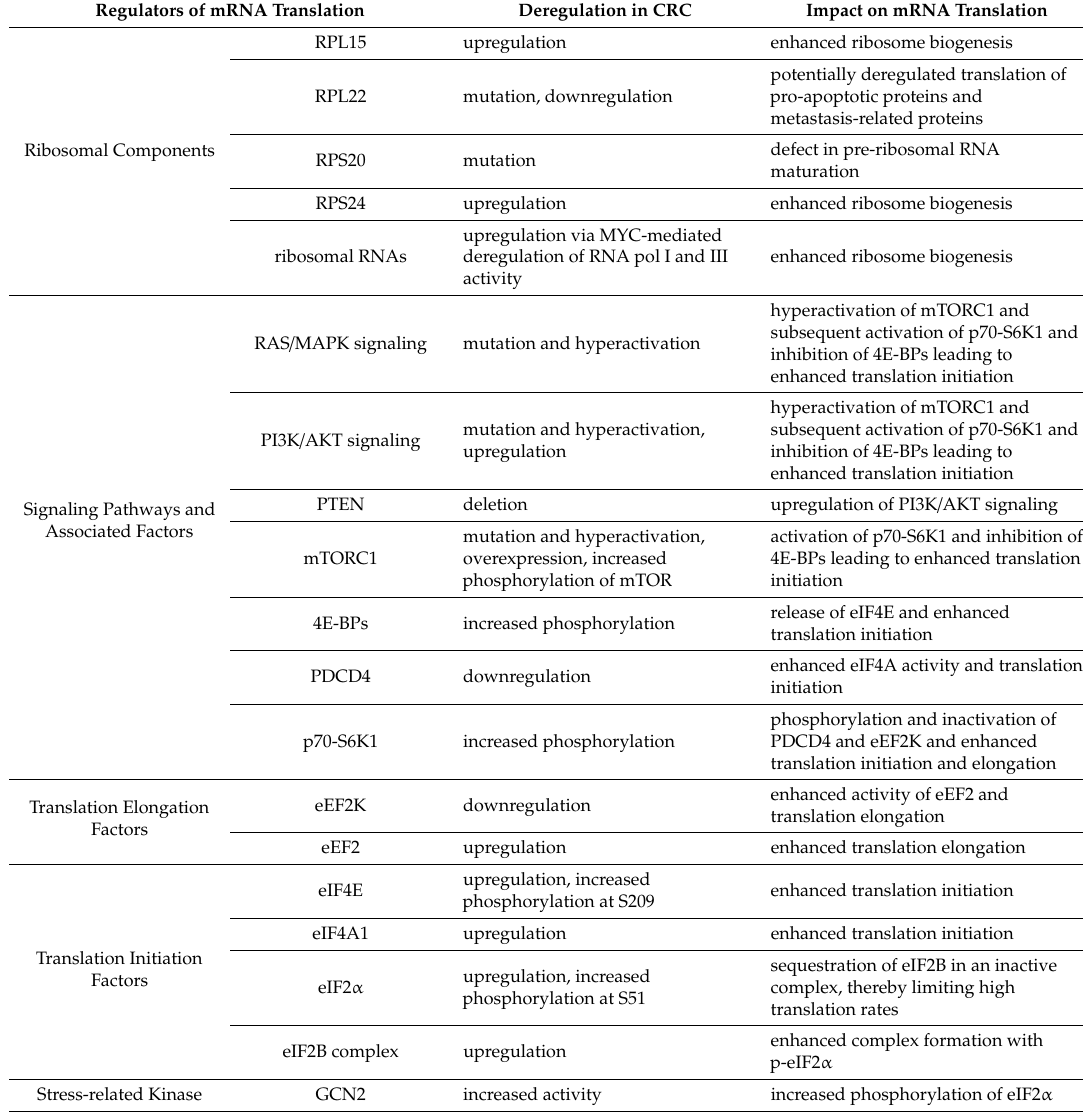
Table 1. Deregulated factors and pathways in